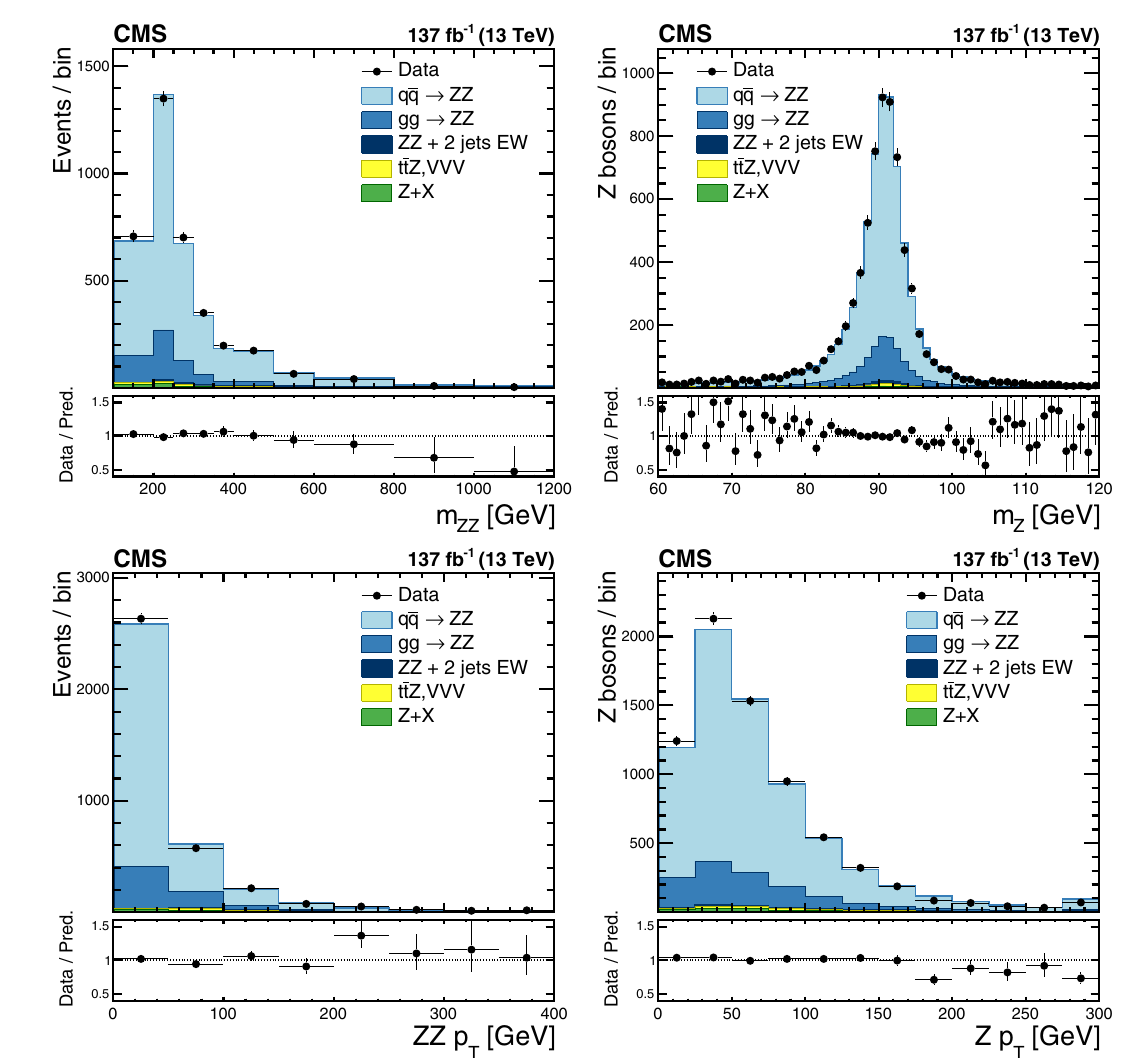
Fig. 2 Distributions of (upper left) m ZZ for ZZ events with < 120GeV; (upper right) mass of selected Z boson can- 60 < m Z 1 , Z 2 didates; (lower left) transverse momentum of the ZZ system; (lower right) transverse momentum of individual Z boson candidates. Points